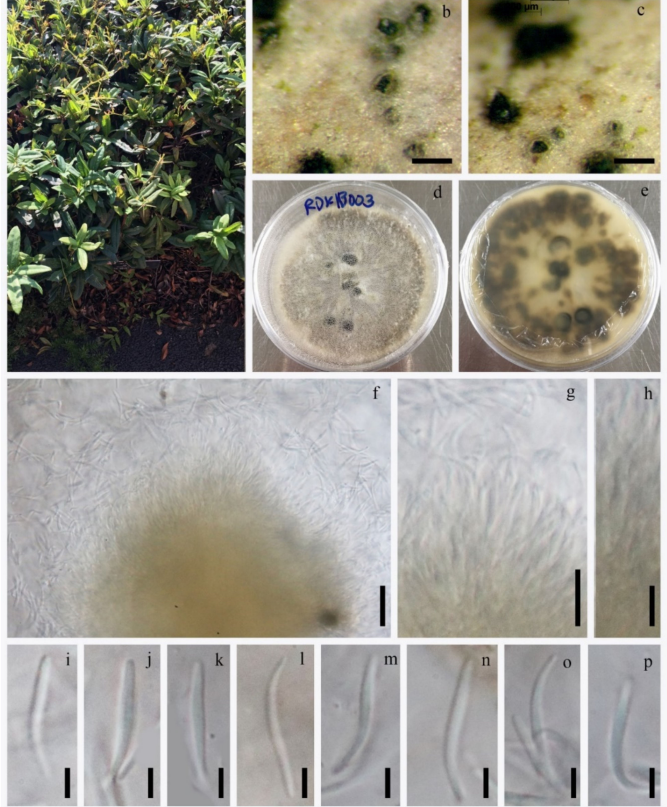
Figure 7. Diaporthe nobilis (KUN-HKAS 123203). ( a ) Habitat of host; ( b , c ) appearance of fungi on host surface; ( d , e ) culture characters on PDA; ( g , h ) conidiophore with attached conidium; ( i – p ) conidia. Scale bars: ( b , c ) 200 µ m; ( d – f , i – p ) 10 µ